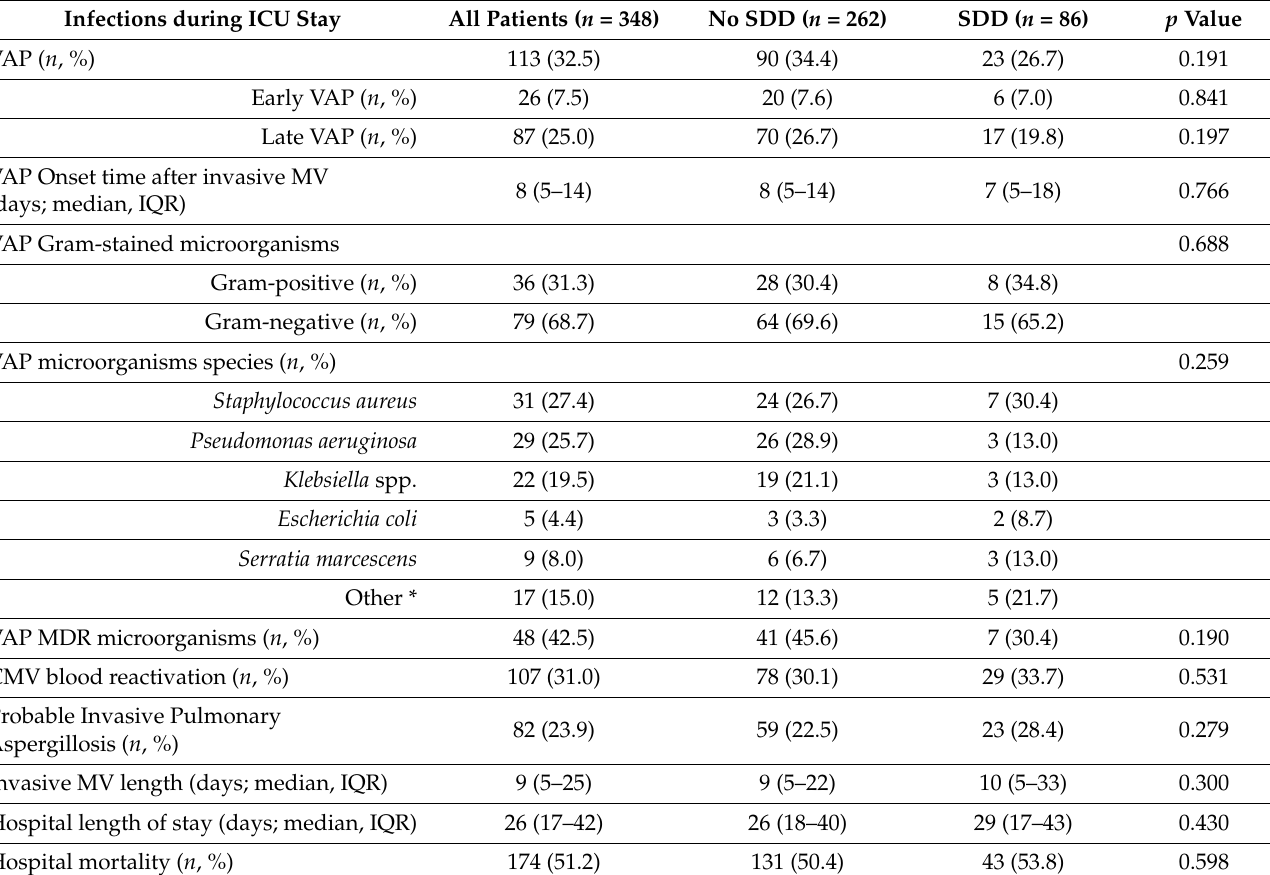
Table 2. Ventilator-associated pneumonia, and other infections during intensive care stay and hospital mortality in all the patients and in patients receiving and not receiving selective digestive